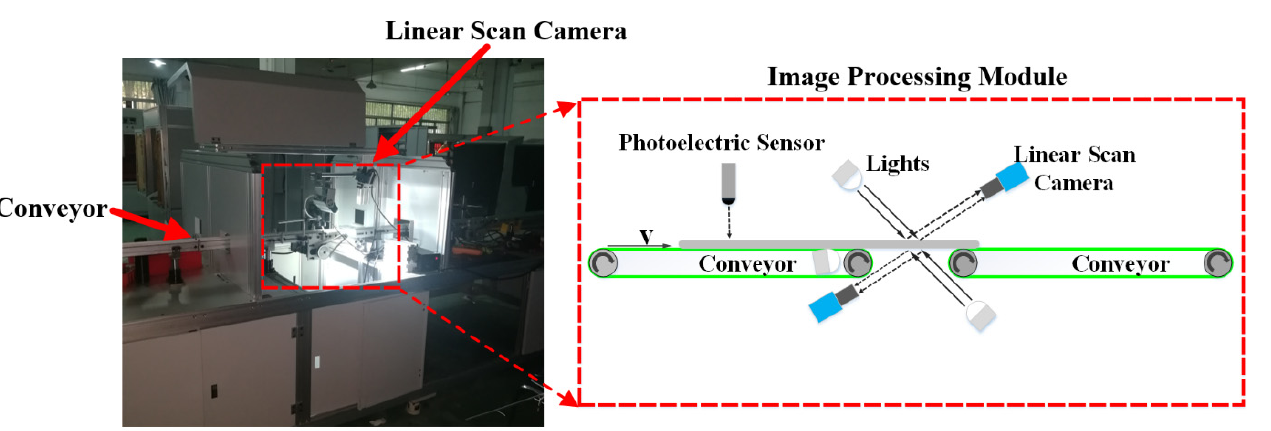
Figure 9. The detection and experimental system.